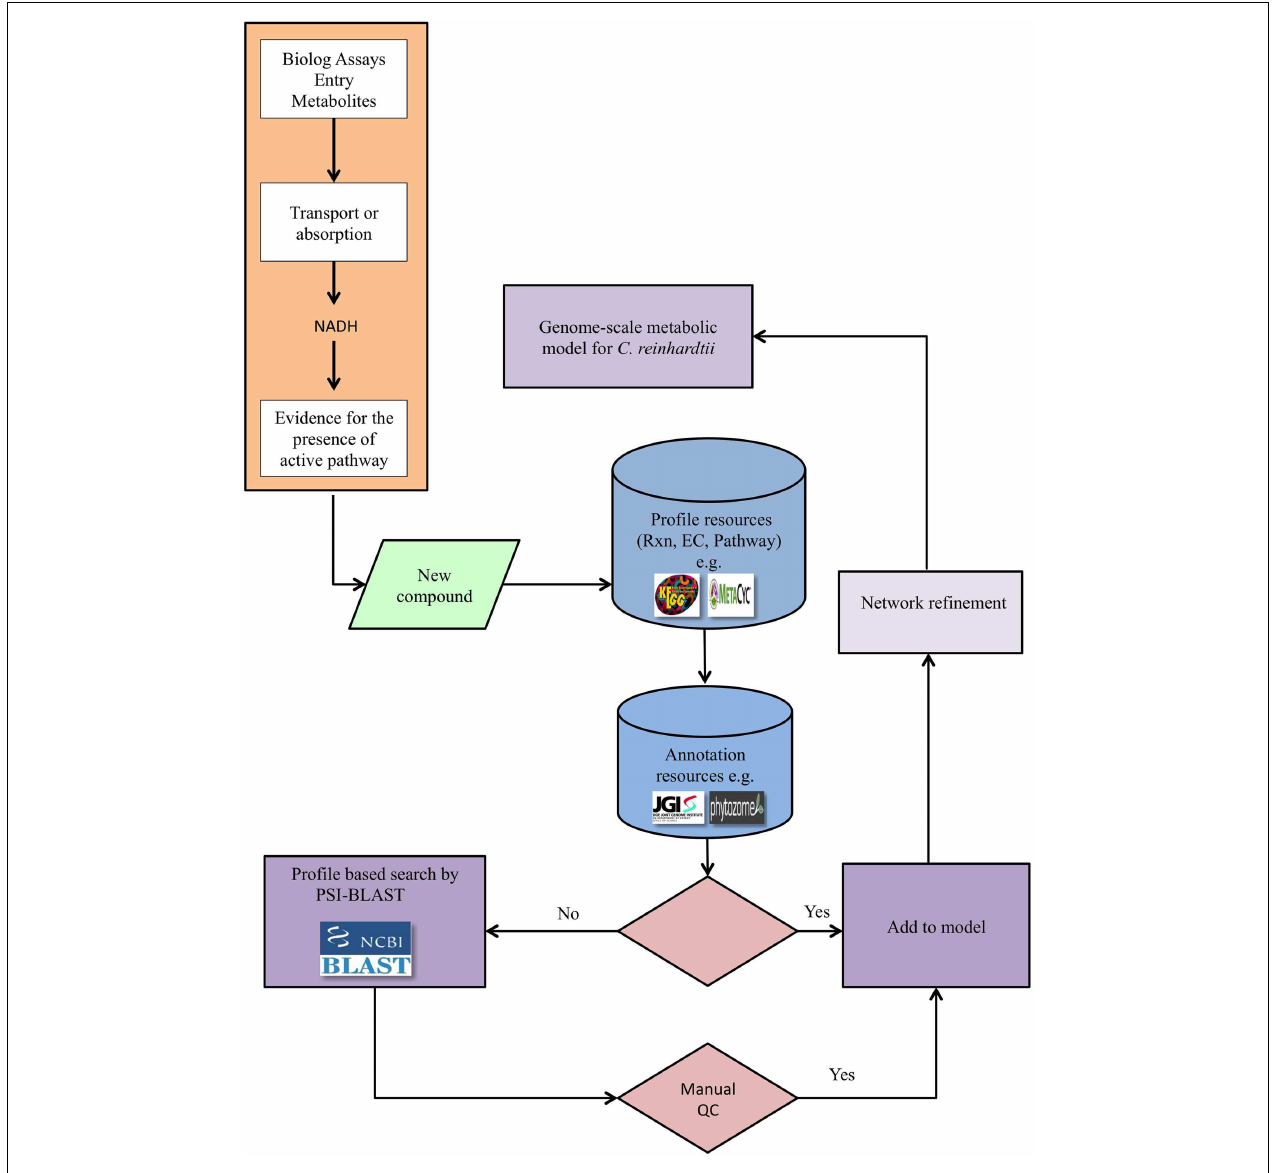
phenotype.When direct genomic evidence is unavailable, the protein sequence is identified from the EC numbers and through the protein sequence, genetic evidence is identified via PSI-BLAST.The reconstructed metabolic network is then refined based on newly identified compounds, but only after a quality control step.The quality control step entails querying the protein domains using relevant